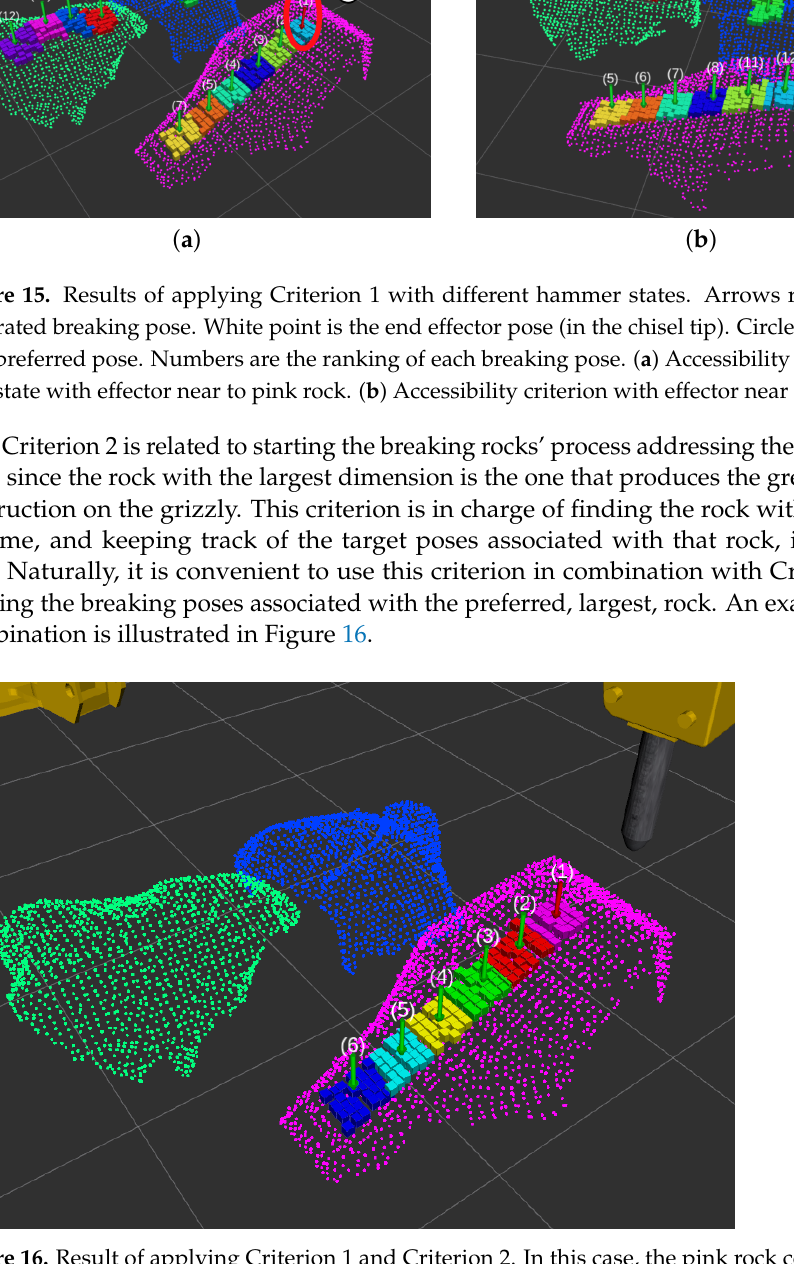
Figure 16. Result of applying Criterion 1 and Criterion 2. In this case, the pink rock corresponds to the largest rock and numbered arrows represents the generated breaking